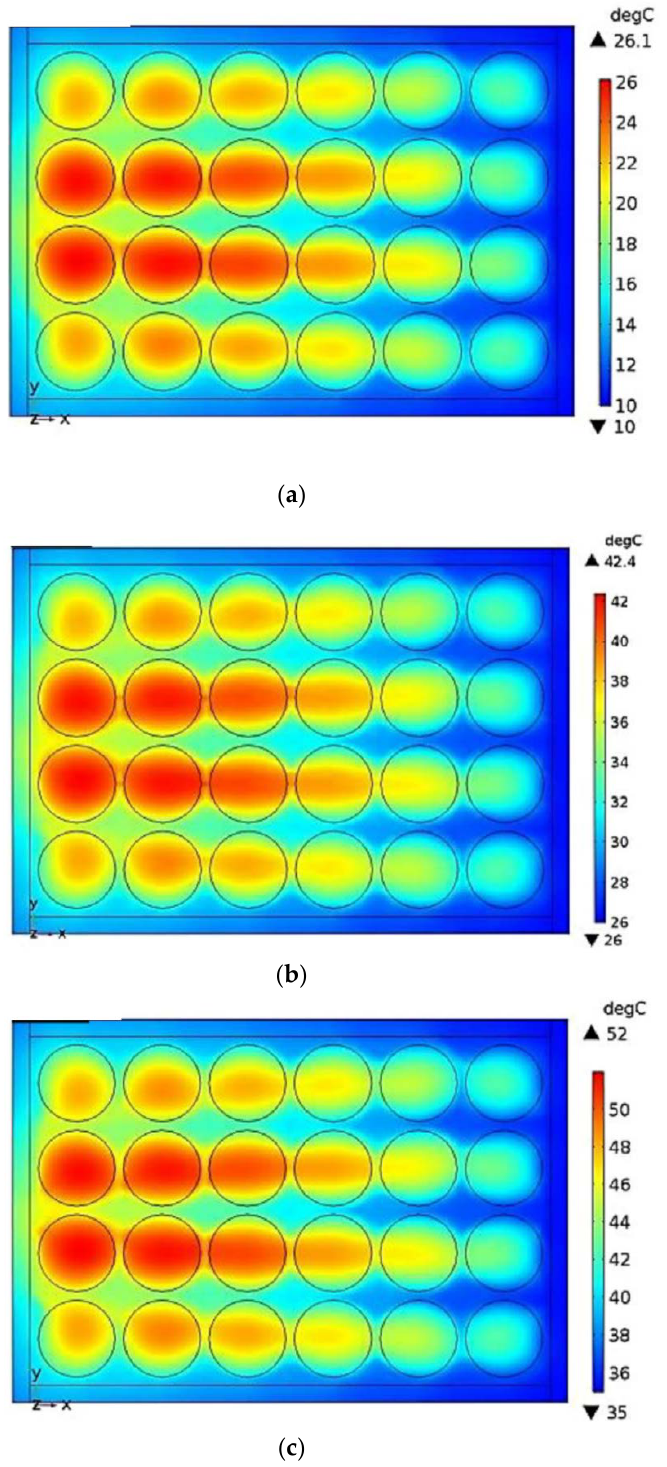
Figure 5. Battery surface temperatures at T amb of ( a ) 10 °C, ( b ) 26 °C, and ( c ) 35 °C (from Behi et al. [52], with permission from Elsevier).